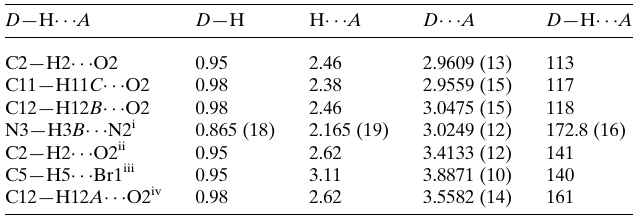
Table 1 Hydrogen-bond geometry (A˚ , (cid:2) ).